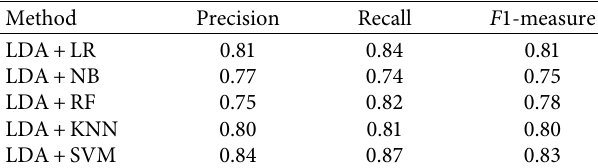
Table 4: Classification effect of topic feature